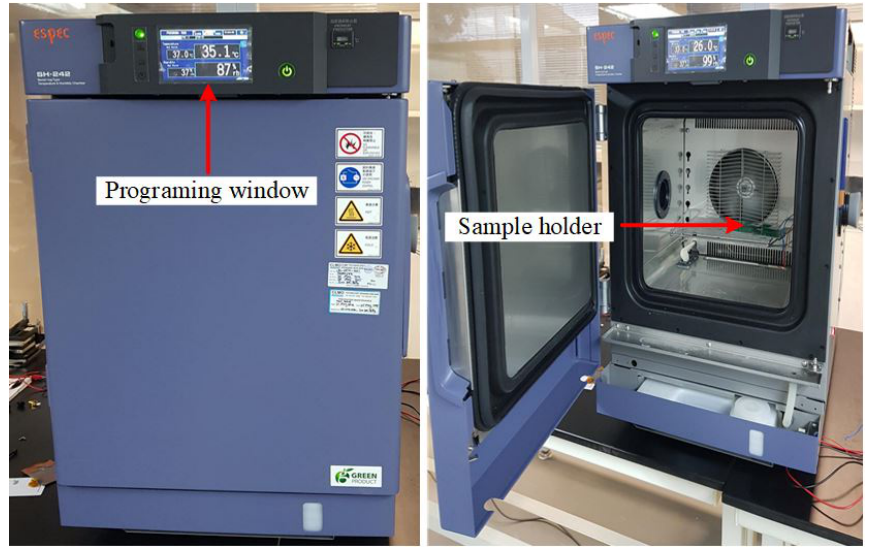
Figure 18. Closed and open SH-242 temperature and humidity